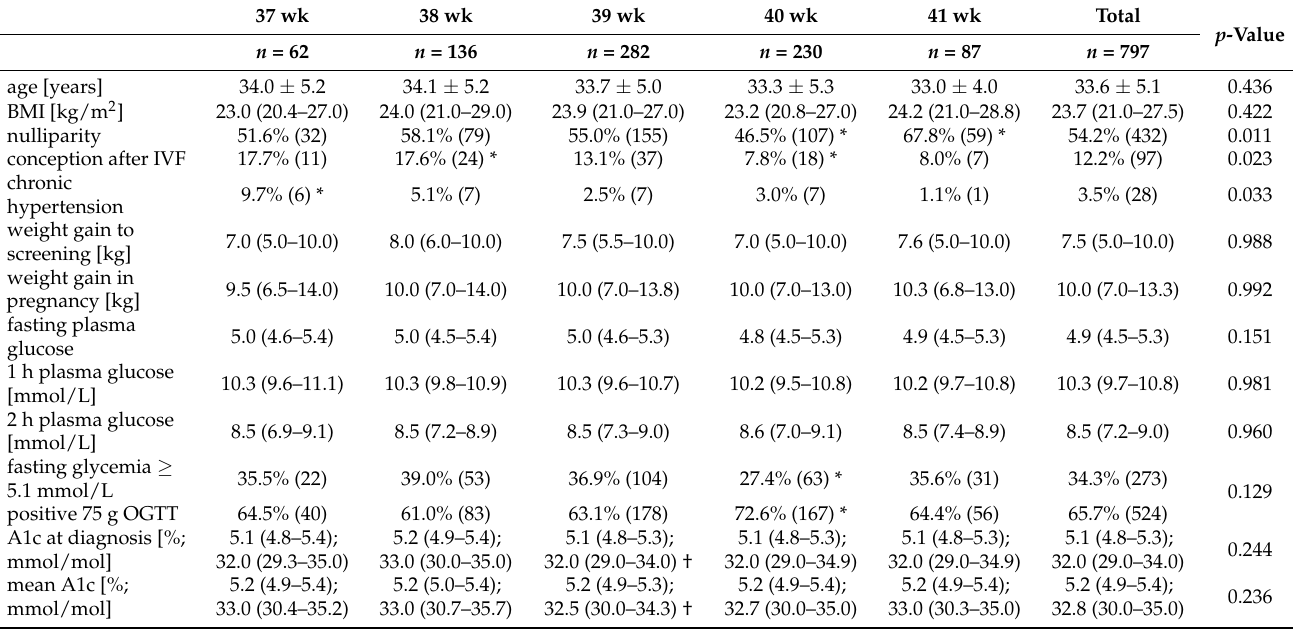
Table 1. Pregnancy characteristics stratified by gestational age.